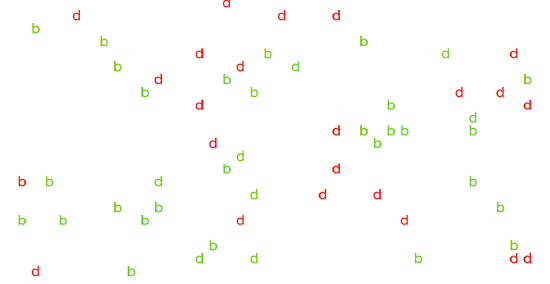
Figure 1: A trial of abstract conjunctive search. Partic- ipant’s task was to find a red letter “b” among